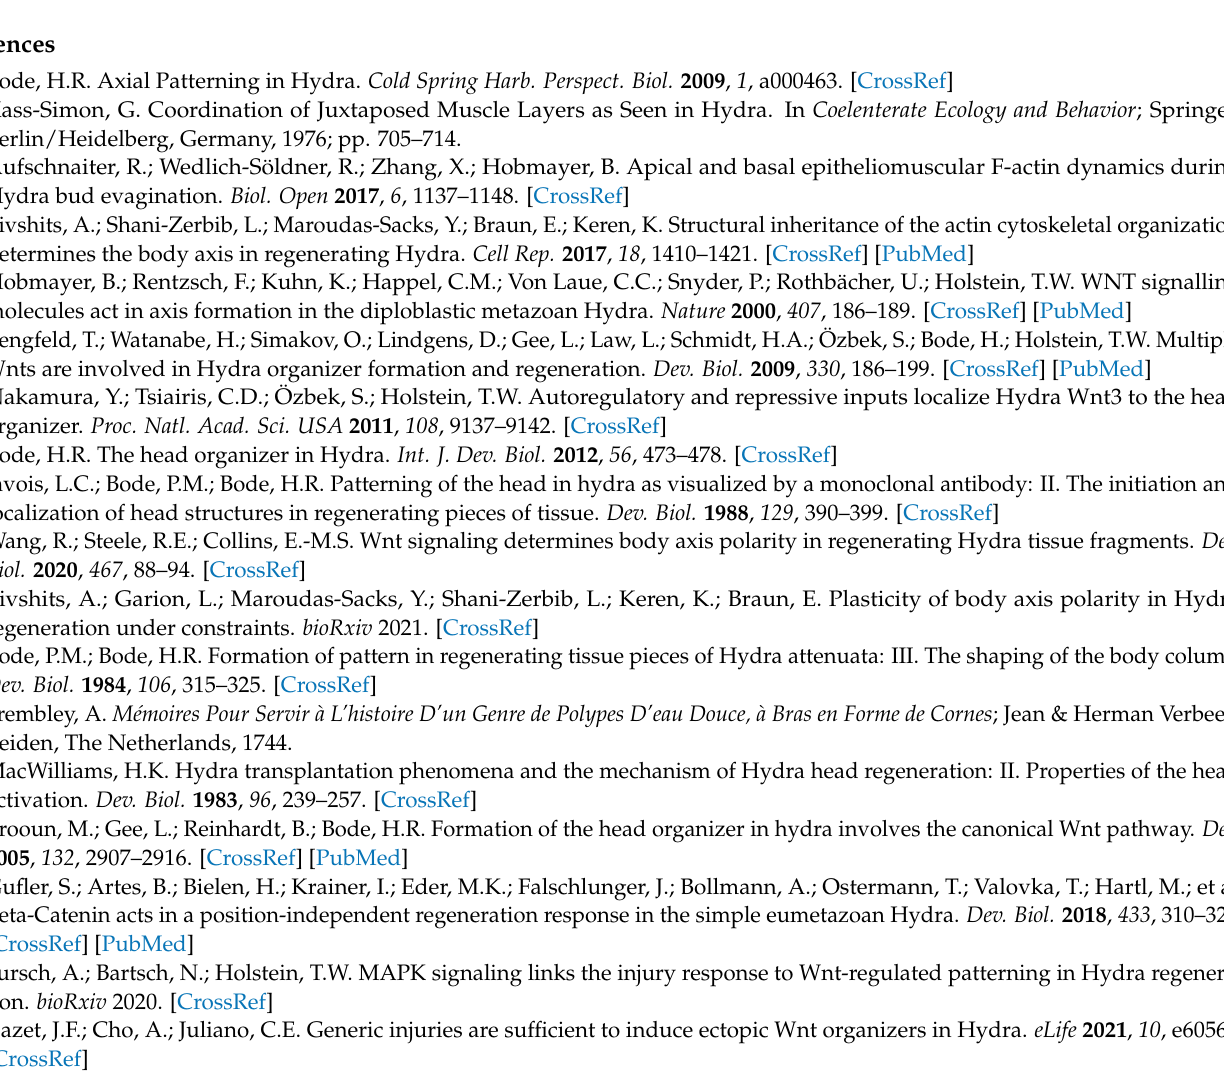
Figure S2: Size and shape of a rectangular tissue strip, Figure S3: The shape of the initial folded spheroid, Figure S4: Tissue dynamics and actin fiber organization during regeneration of strips labeled along a medial or central line, Movie S1: Tissue dynamics in regenerating tissue strips labeled along the central line, Movie S2: Tissue dynamics in a regenerating strip viewed from its back side, Movie S3: Tissue dynamics in a regenerating strip viewed from its front side, Movie S4: Actin fiber reorganization around the head region of a regenerating tissue strip. Movie S5: Actin fiber reorganization around the foot region of a regenerating tissue